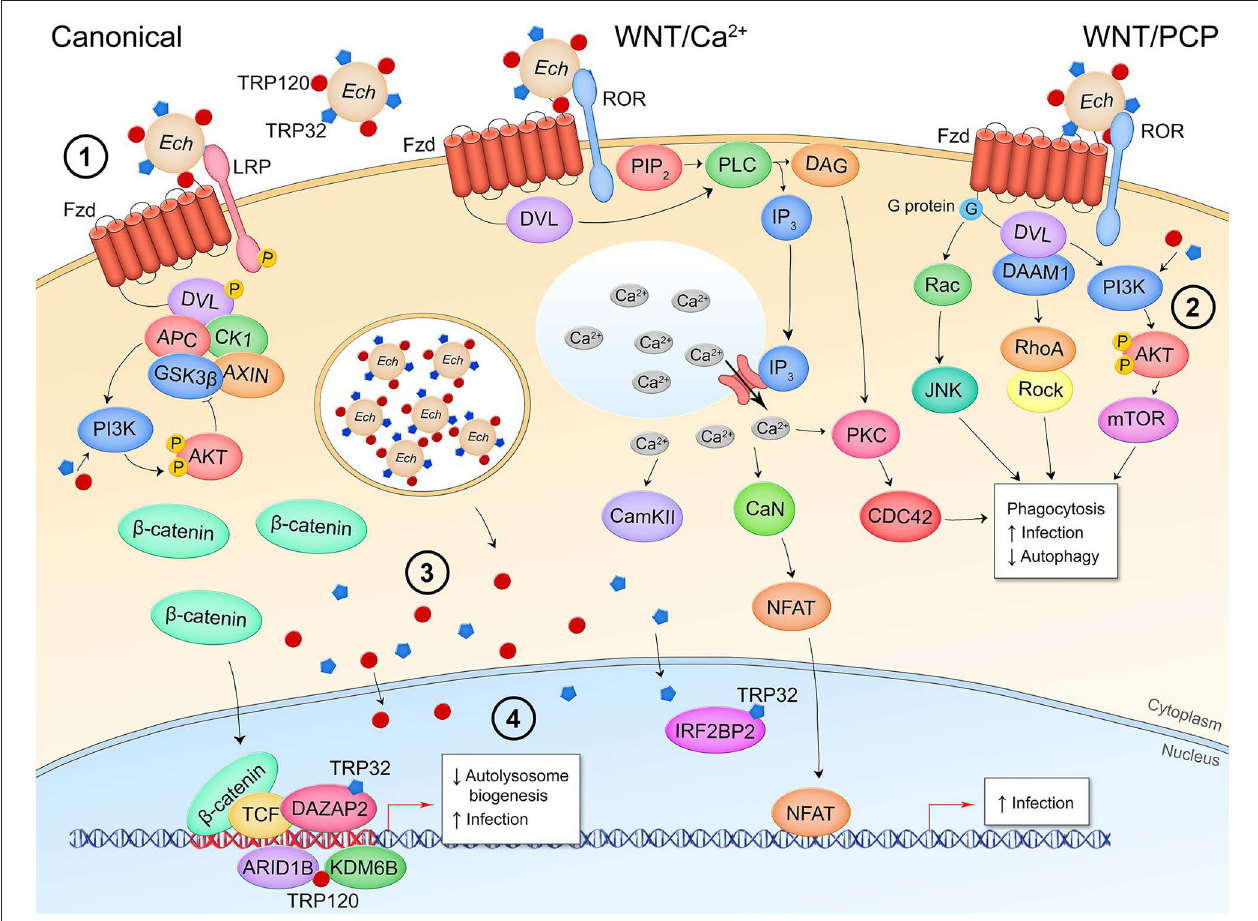
FIGURE 5 | Canonical and non-canonical Wnt signaling manipulation during E. chaffeensis infection of monocytes. (1) E. chaffeensis dense-cored cells express surface proteins TRP32 and TRP120 that stimulate phagocytosis in a Wnt signaling-dependent manner, potentially through interaction with the Wnt receptor complex and stimulation of non-canonical Wnt pathways to induce cytosolic Ca 2 + flux and cytoskeletal reorganization. (2) Pathway activity during bacterial entry as well as T1SS secreted effectors TRP32 and TRP120 direct stimulation of PI3K-AKT signaling facilitates mTOR activation which prevents fusion of the bacterial replicative autophagosome with the lysosome. During infection, the secreted TRP effectors localize to the host cytoplasm where they interact with proteins involved in Wnt signaling (3) as well as translocate to the nucleus where they bind host DNA within the promoter regions of Wnt target genes or directly interact with transcriptional regulators of Wnt target genes